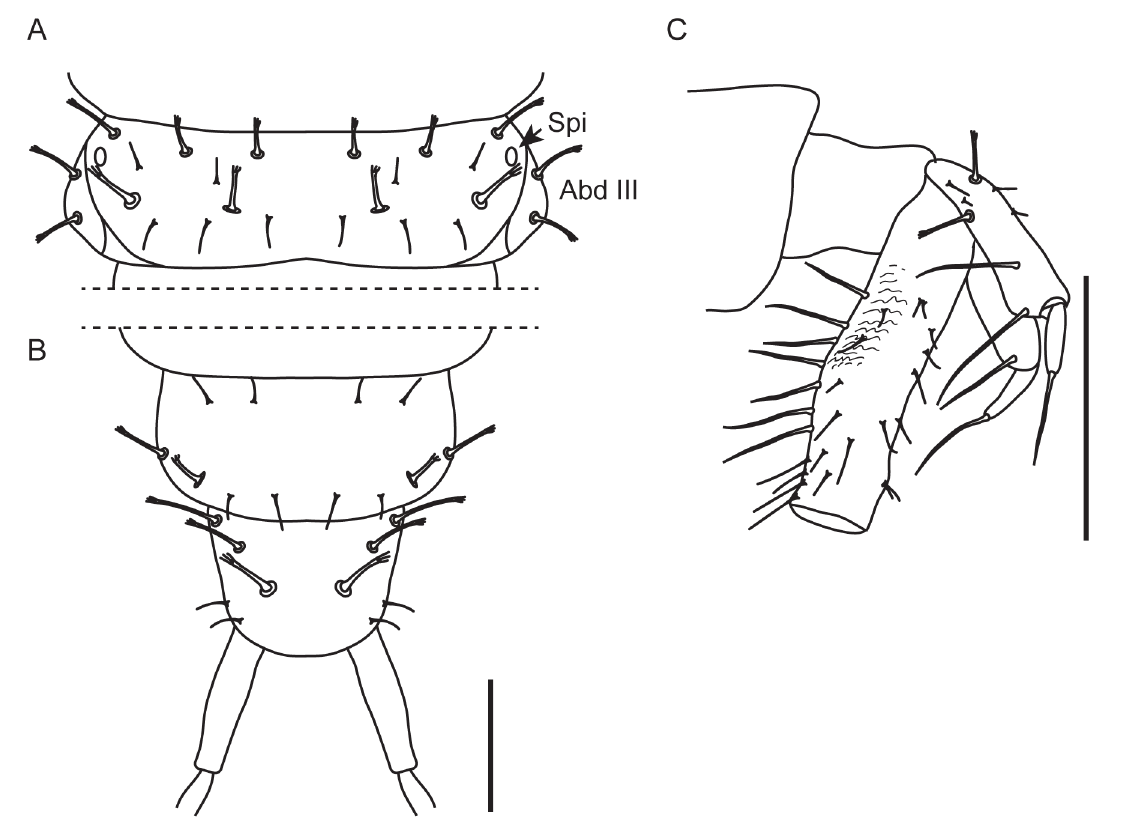
Fig. 8. Quedius masuzoi Watanabe, 1989. Morphology of larva: abdomen. A . Abdominal segment III, dorsal view. B . Apex of abdomen, dorsal view. C . Apex of abdomen, lateral view. Abbreviations: Abd III = abdominal segment III; Spi = spiracle. Scale bars = 0.5